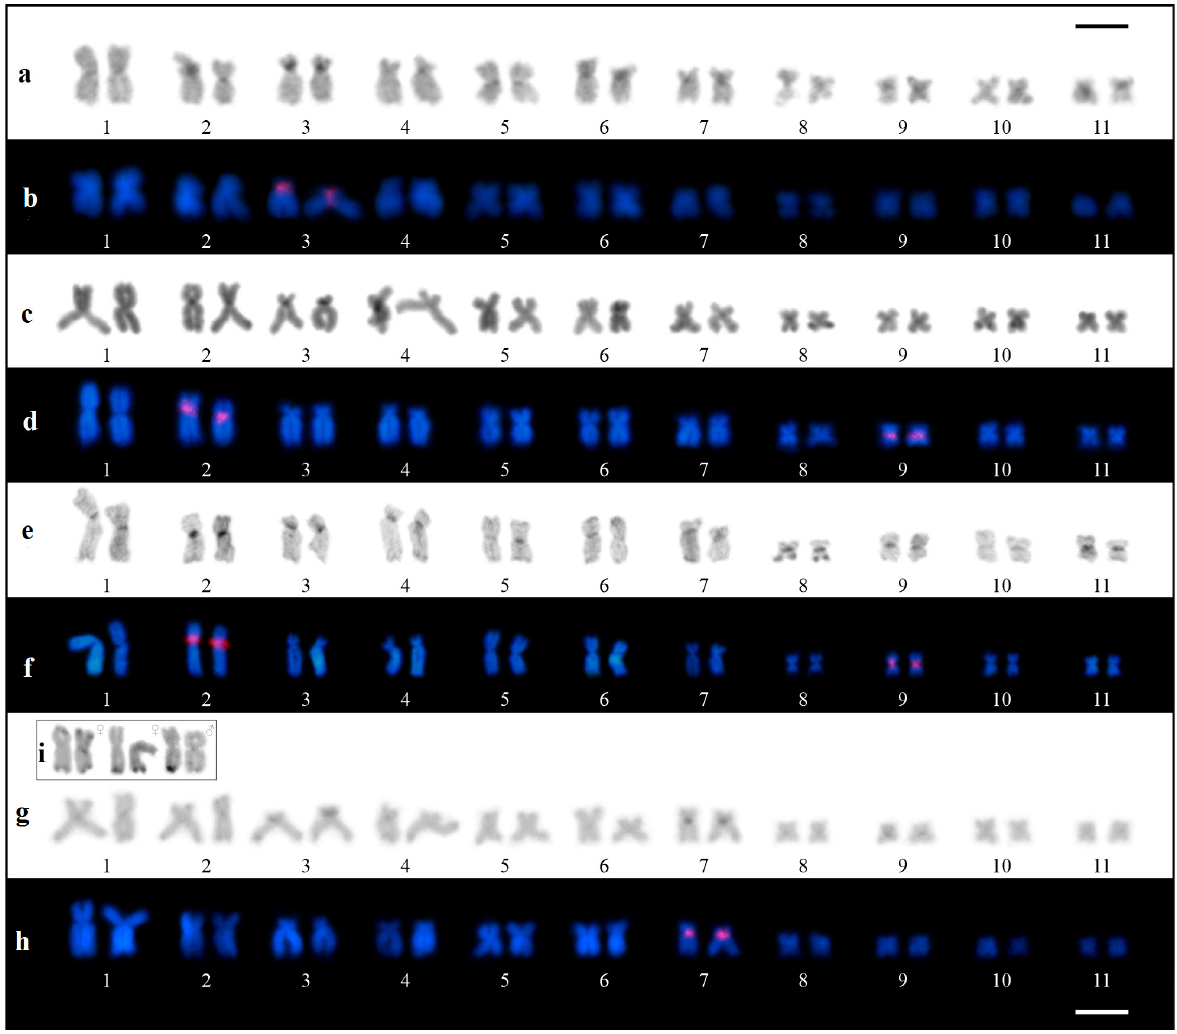
Figure 2. Mitotic chromosomes of four species of the Physalaemus gracilis group after C-banding (a, c, e, g, i) and FISH with PcP190 satDNA (b, d, f, h). (a, b) P. carrizorum , (c, d) P. gracilis , (e, f) P. sp. aff. gracilis , (g,i) P. lisei. The polymorphic variation for C-bands of pair 1 in P. lisei are shown in (i). Bar = 10